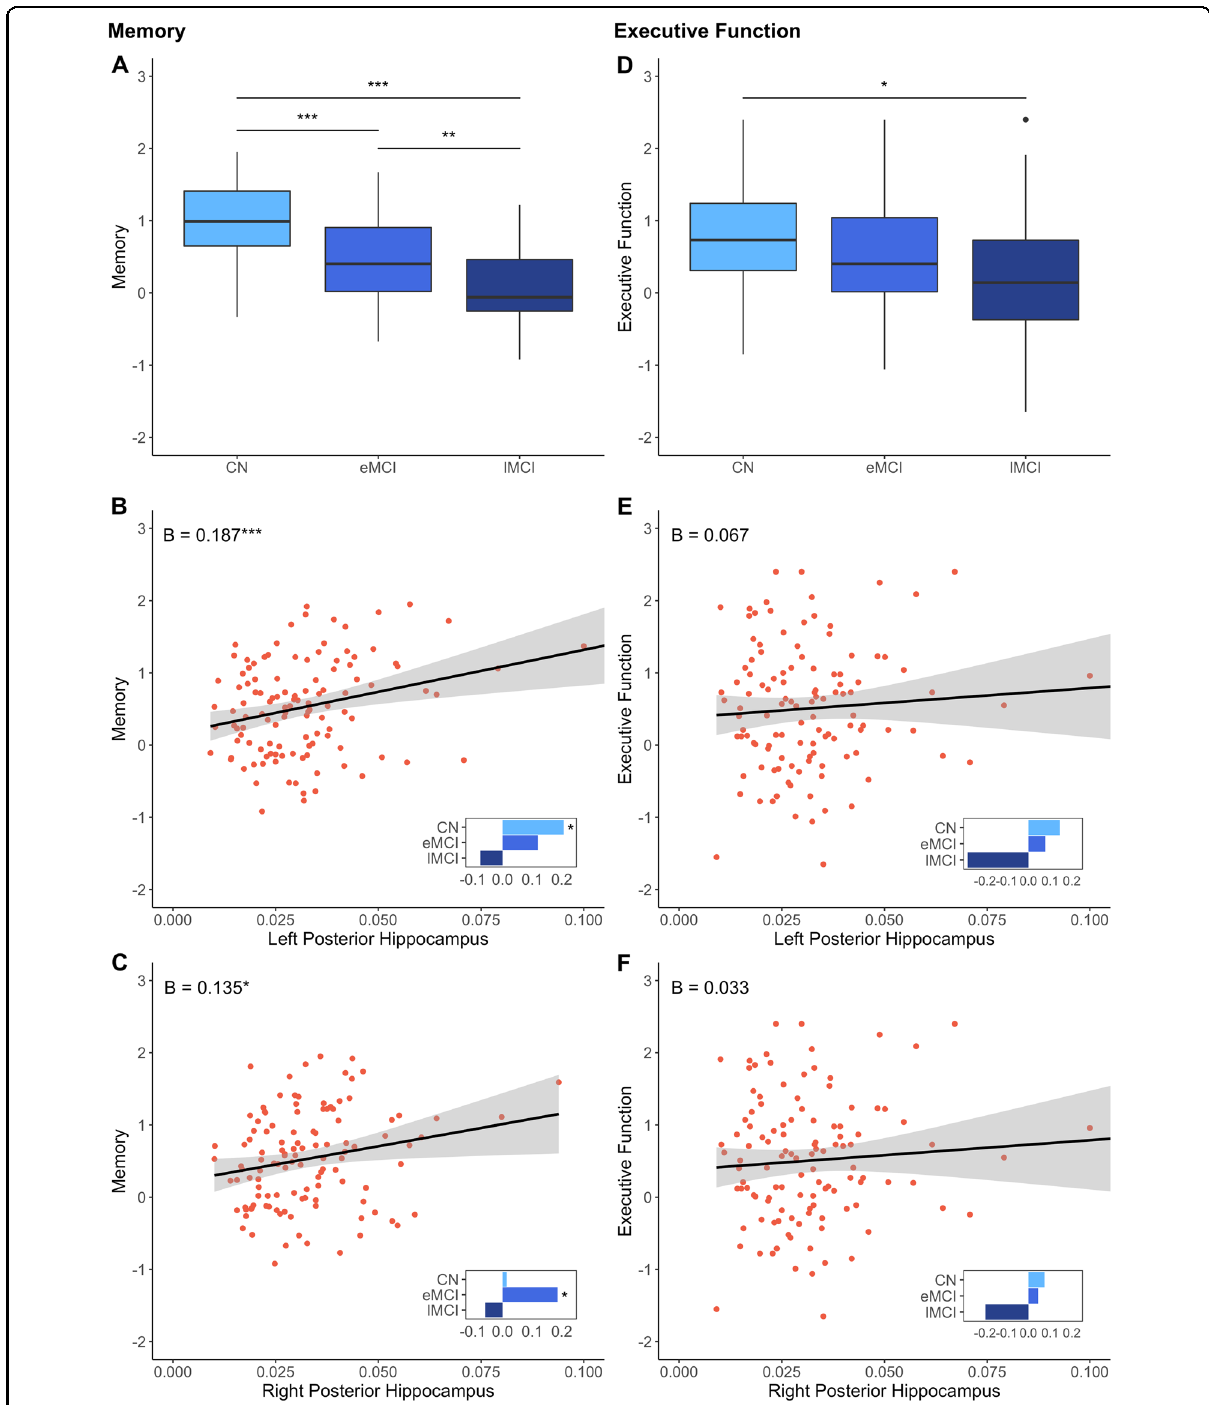
Fig. 3 Relationship between redundancy and cognitive performance. A Memory composite scores across groups. Boxplot denotes the median (bold bar), fi rst and third quartiles (box limits), and ±1.5 times the interquartile range (whiskers). B Whole sample regression of left posterior hippocampal redundancy on memory composite score. Inset shows within-group regression β -weights. C Whole sample regression of right posterior hippocampal redundancy on memory composite score. Inset shows within-group regression β -weights. D Executive function composite scores across cognitive groups. Boxplot denotes the median (bold bar), fi rst and third quartiles (box limits), and ±1.5 times the interquartile range (whiskers). E Whole sample regression of left posterior hippocampal redundancy on executive function composite score. Inset shows within-group regression β -weights. F Whole sample regression of the right posterior hippocampal redundancy on executive function composite score. Inset shows within- group regression β -weights. * p < 0.05, ** p < 0.01, *** p <